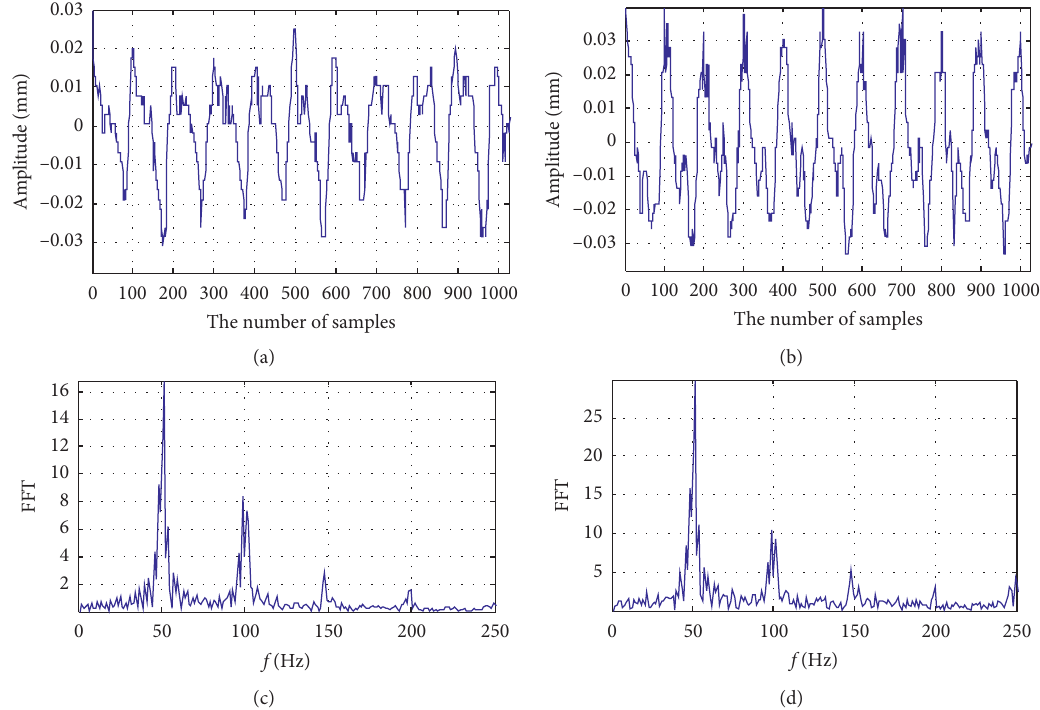
Figure 8: Time-domain and frequency-domain waveforms of the signals after denoising using the proposed